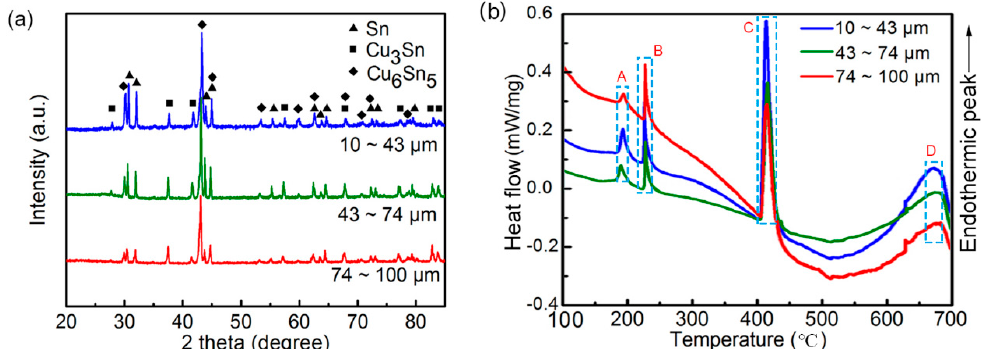
Figure 3. X-ray diffraction (XRD) patterns ( a ), and differential scanning calorimetry (DSC) patterns ( b ) of the atomized Cu–Sn alloy powders with different size.